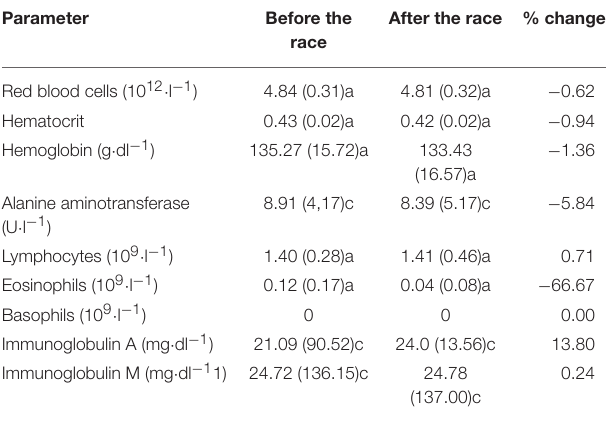
TABLE 2 | Comparison of immunological, hematological, and biochemical parameters before and after the race (Mean ± SD and % change) without statistically significant